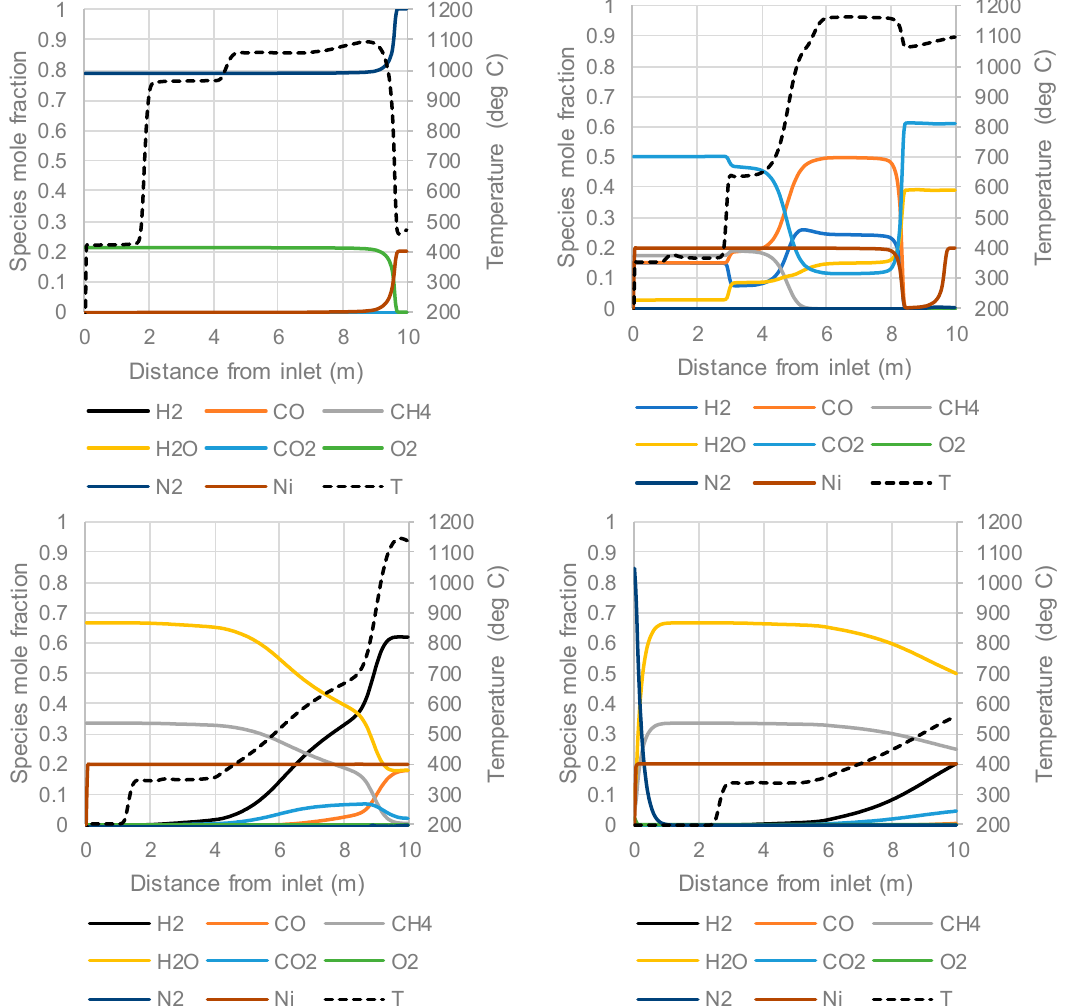
Figure 5. Axial profiles of species and temperature in the PBCLR reactor at: the end of the oxidation stage [ top left —900 s in Figure 4]; end of the reduction stage [ top right —1500 s in Figure 4]; middle of the reforming stage [ bottom left —1950 s in Figure 4]; and end of the reforming stage [ bottom right —2400 s in Figure 4].